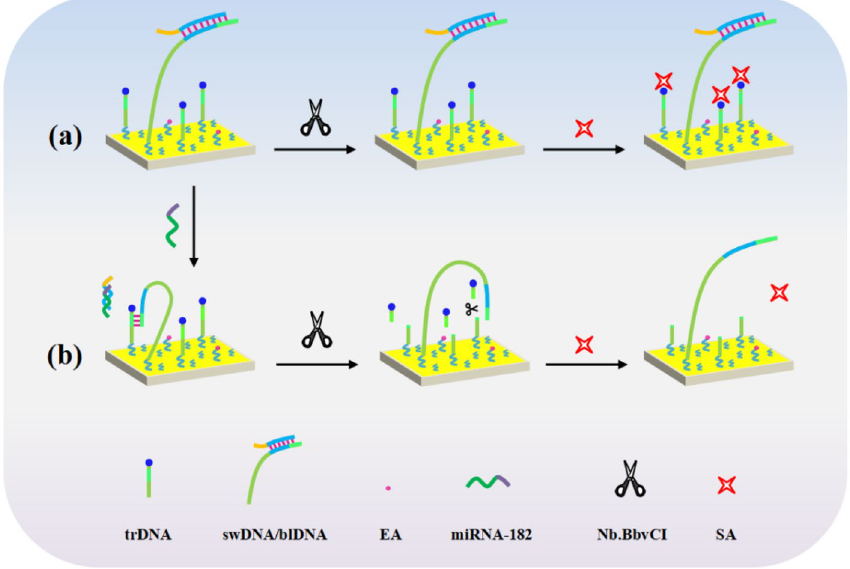
Figure 1. Schematic representation of SPR assay of miRNA based on DNA walking process integrated with enzymatic cleavage